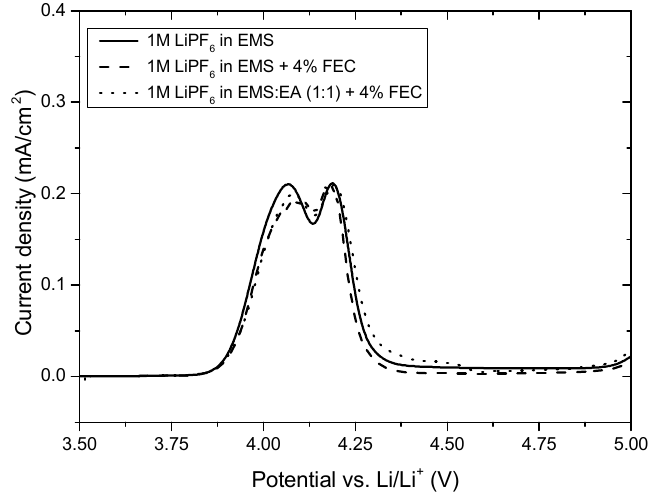
Figure 8. Electrochemical stability window of 1 M LiPF 6 in EMS, 1 M LiPF 6 in EMS + 4% FEC and 1 M LiPF 6 in EMS:EA + 4% FEC, respectively on LMO (WE) using lithium as both CE and RE, at a scan rate of 100 µ V · s − 1 .